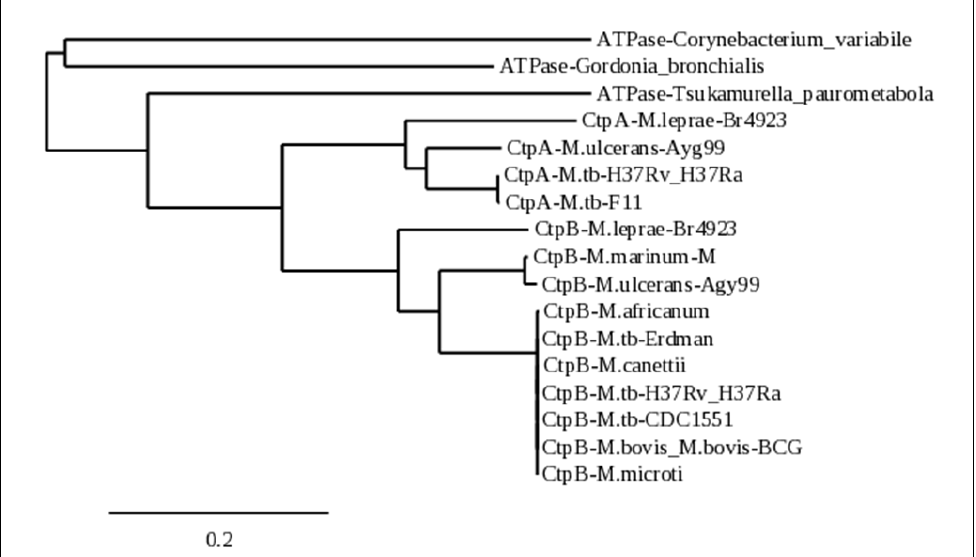
Figure 6. CtpB conservation among intracellular pathogenic Mycobacterium species. The phylogenetic tree was rendered with Phylogeny (http://www.phylogeny.fr/ (accessed on 2 April 2022)), the alignment of CtpB homologs from mycobacterial strains of interest and top hits of homologs were obtained through the Mycobrowser precomputed nonredundant protein BLAST search results for the M. tuberculosis H37Rv CtpB. Representative homologs for the M. tuberculosis (M.tb) complex, M. marinum / M. ulcerans , and M. leprae clades are shown. Branches with a support value less than 50% are collapsed. Genbank entries used: NP_214617.1, WP_003400797.1, YP_004743591, CCC25178.1,